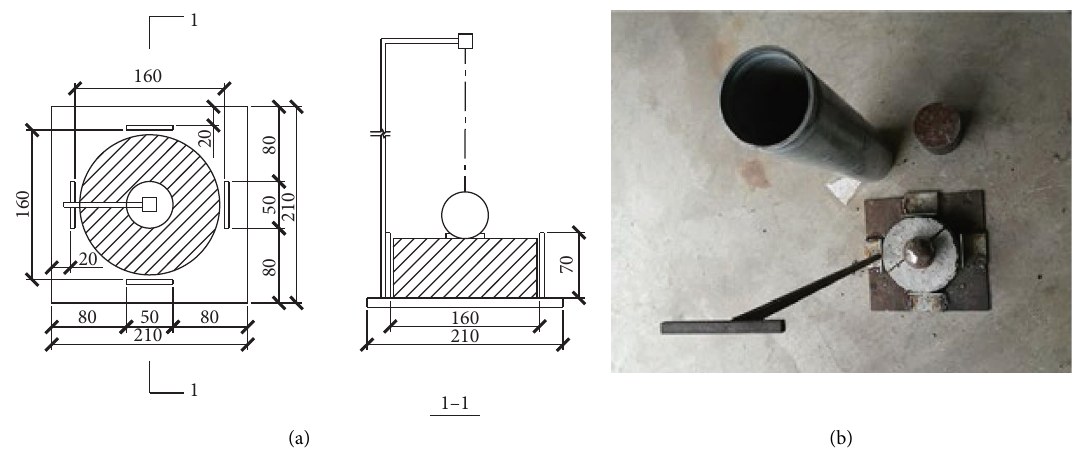
Figure 5: ARGFRC impact resistance test: (a) test setup (mm); (b) impact resistance test (top